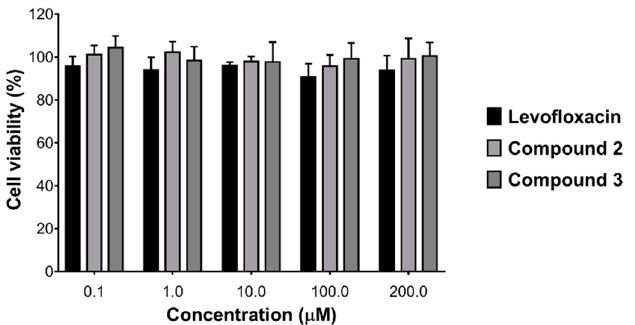
Figure 2. Cell viability of human dermal fibroblasts treated with various concentrations of compounds 2 and 3 and levofloxacin for 48 h.